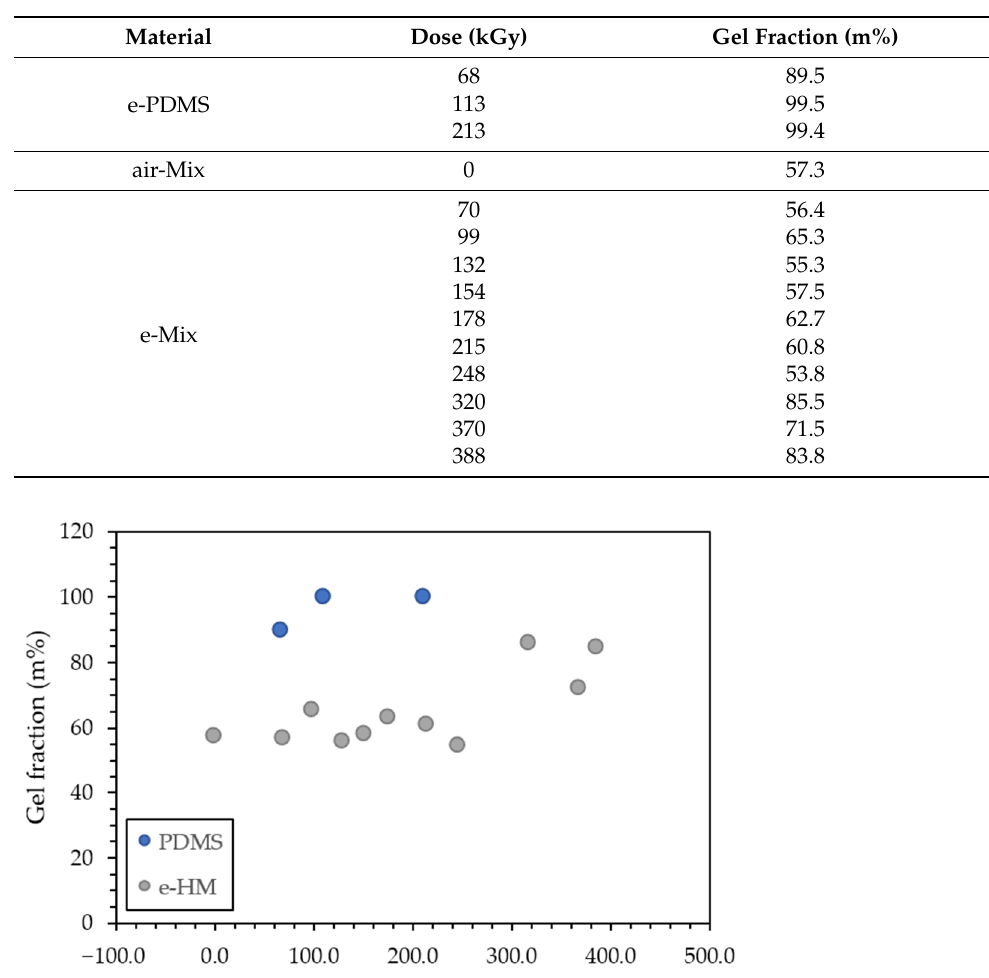
Table 2. Calculated gel fraction in mass percentage (m%).